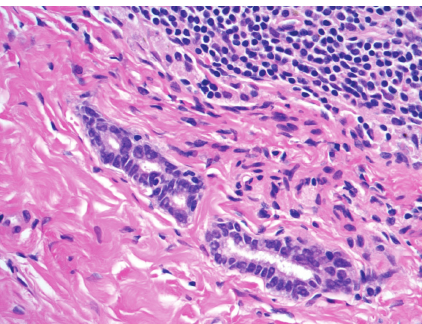
Figure2:Photomicrographofglandularepithelialstructureswithin the capsular tissue of a postneoadjuvant, ipsilateral, and axillary sen- tinel lymph node (Hematoxylin and Eosin [H&E] stain, original magnification 400x).